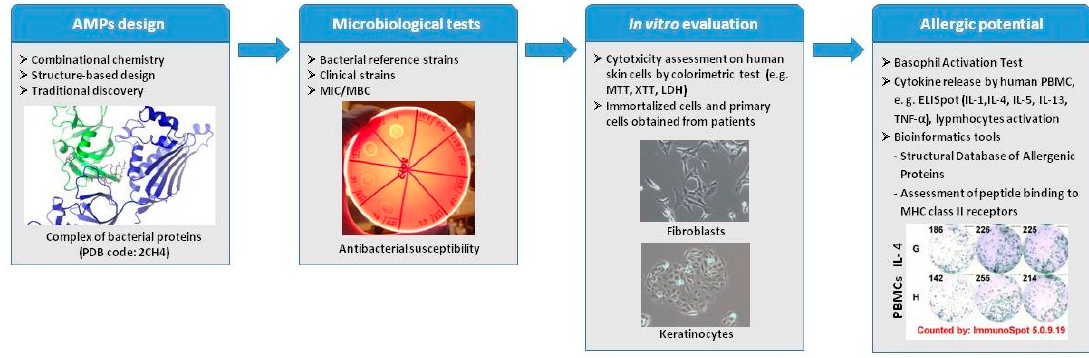
Figure 1. Preclinical evaluation of AMPs.